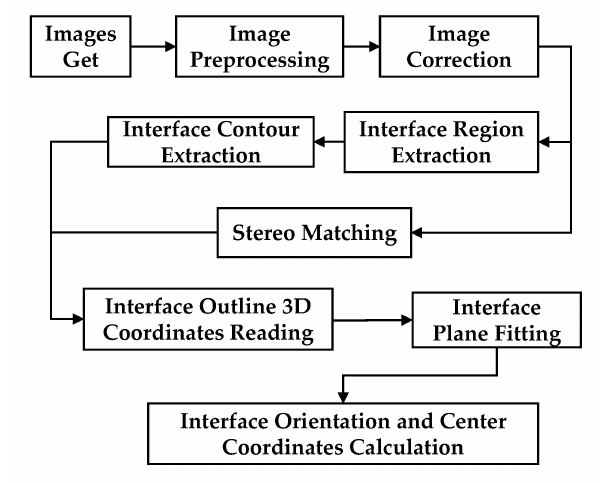
Figure 2. The flowchart of the proposed vision system.